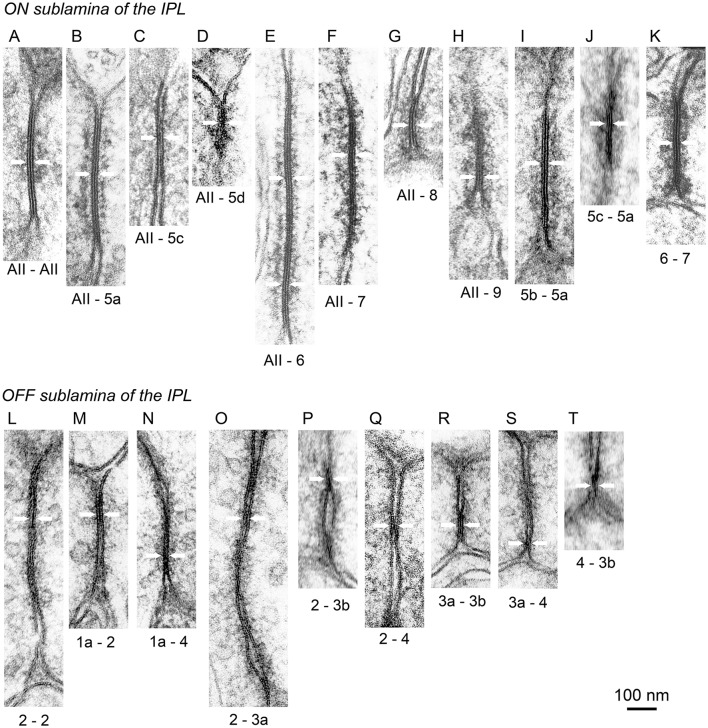
Electron micrographs of gap junctions (pairs of arrows) in the AII amacrine and bipolar cell system. (A–K) In the ON (inner) sublamina of the IPL, gap junctions were found between adjacent AII amacrine cells (A), between AII amacrine and T5a (B), T5c (C), T5d (D), T6 (E), T7 (F), T8 (G), and T9 (H) cells, and between T5b–T5a (I), T5c–T5a (J), and T6–T7 (K) cells. (L–T) In the OFF (outer) sublamina of the IPL, gap junctions were found between adjacent T2 cells (L) and between T1a–T2 (M), T1a–T4 (N), T2–T3a (O), T2–T3b (P), T2–T4 (Q), T3a–T3b (R), T3a–T4 (S), and T4–T3b (T) cells.